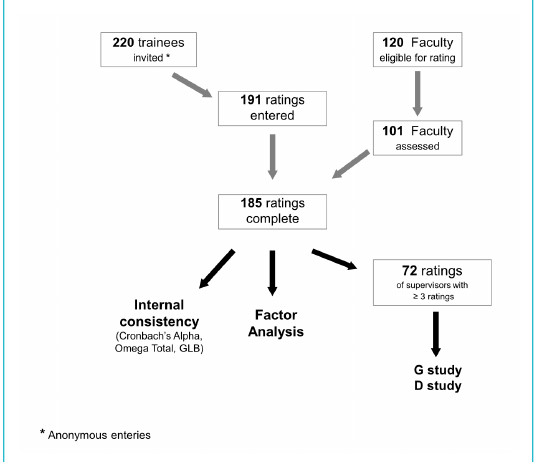
Figure 2: Flow-chart of study design (participants, ratings, and analyses